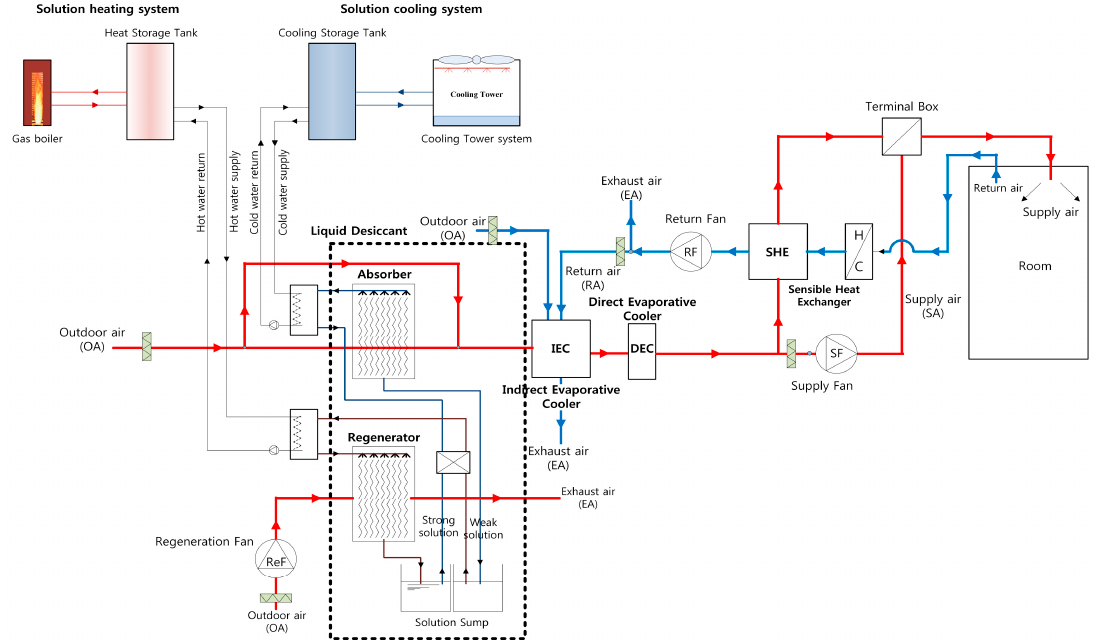
Figure 1. Schematic diagram of an existing liquid desiccant and evaporative cooling-assisted 100% outdoor air system (LD-IDECOAS)